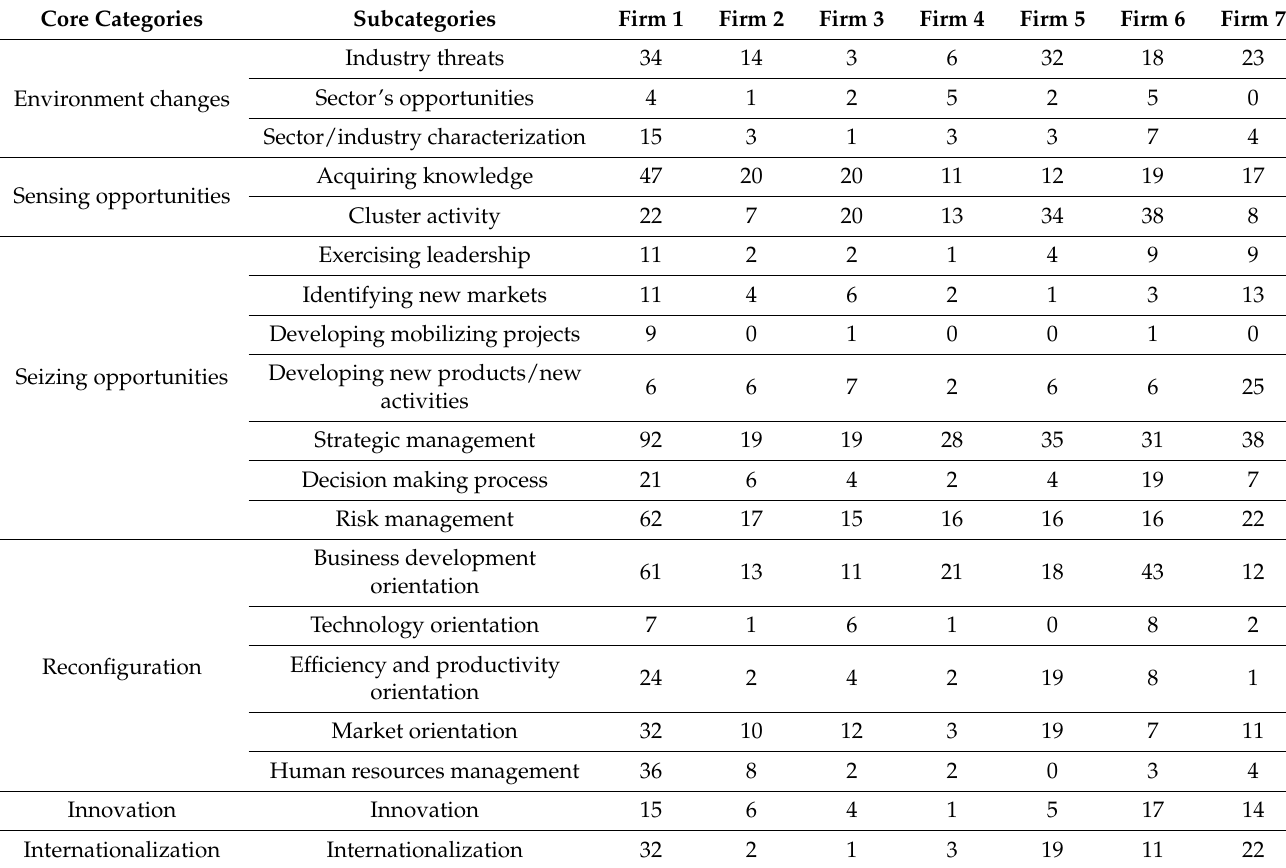
Table 4. Across-case pattern